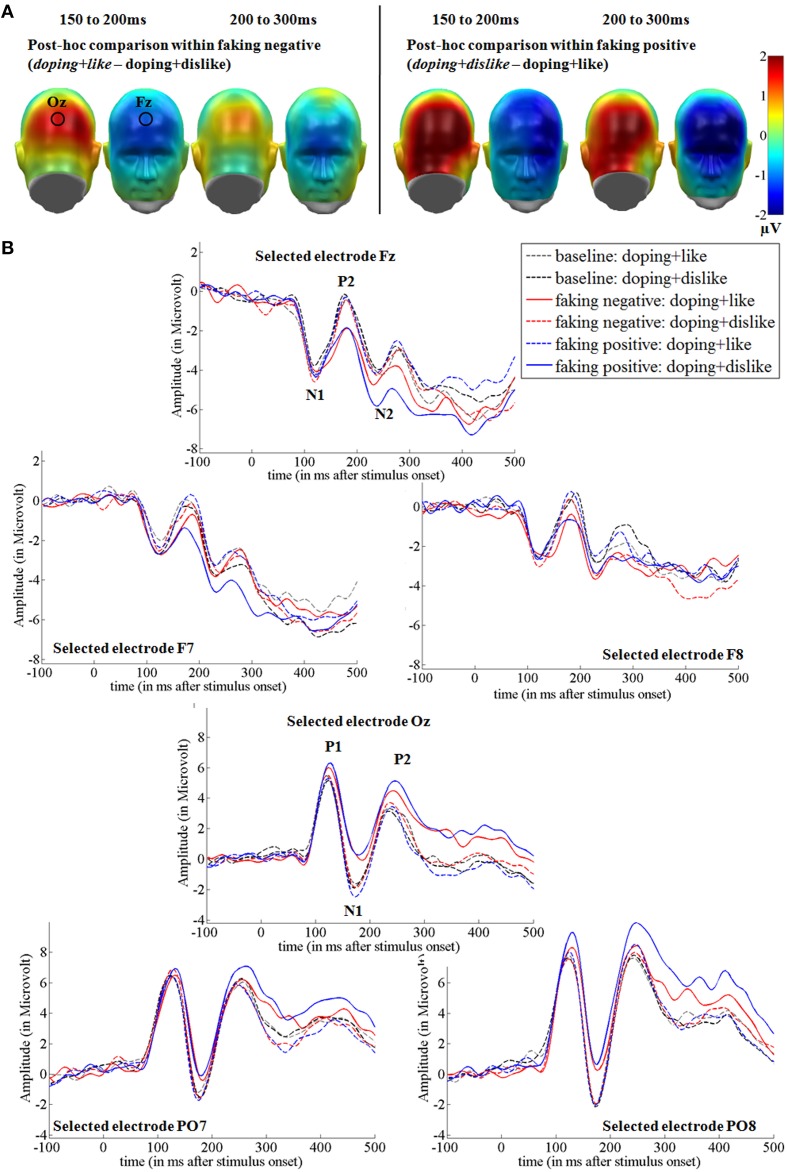
Faking effects on the N1, P2, and N2 components. (A) Difference topographies within the faking negative and the faking positive condition: Blue color indicates more negativity and red color indicates more positivity for the faking blocks (in italics). (B) Selected electrodes F7, Fz, and F8 for the frontal electrode cluster and PO7, Oz, and PO8 for the occipital electrode set, displaying the time course over frontal and occipital sites. Within the faking condition, the respective blocks where participants were instructed to delay their responses are represented by straight lines, whereas baseline blocks are illustrated by dotted lines.